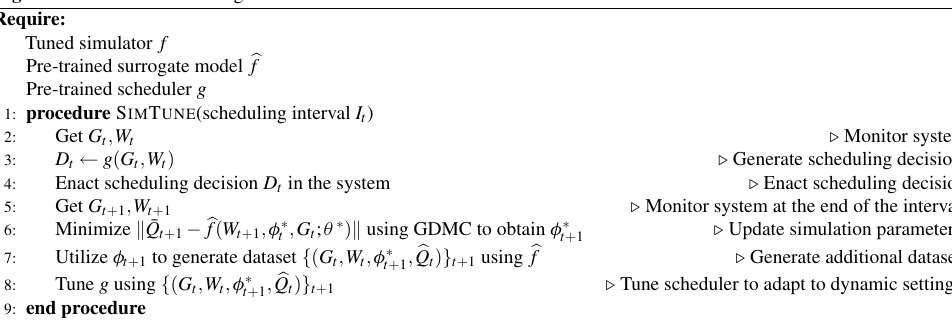
Algorithm 1 Online Scheduling in